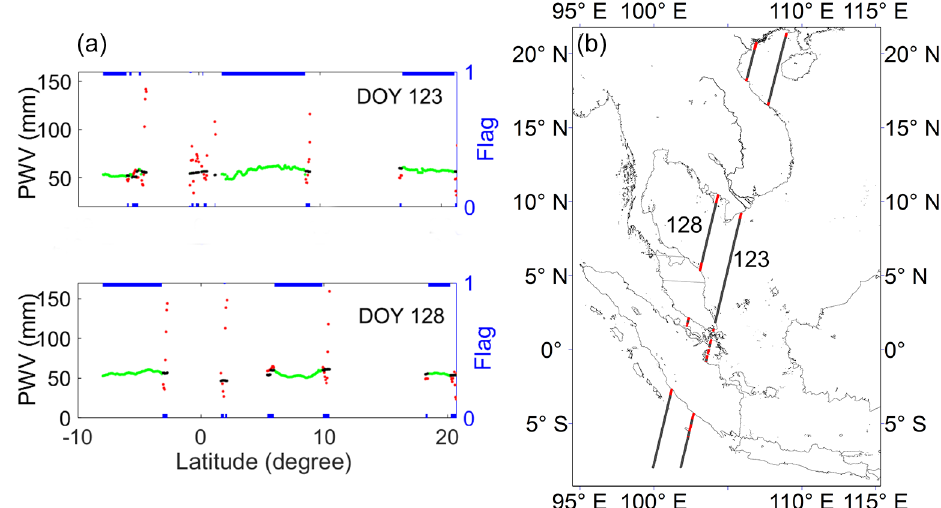
Figure 2. HY-2A PWV observations on DOY 123 (left – upper) and DOY 128 (left – bottom) in 2014, where the clean, contaminated, and reconstructed observations are shown as green dots, red dots, and black dots, respectively. The right y axis is the label of clean points (value 1) and contaminated points (value 0). The right panel illustrates the satellite trajectory on DOY 123 and DOY 128, where the clean and contaminated footprints are shown in gray and red dots, respectively.